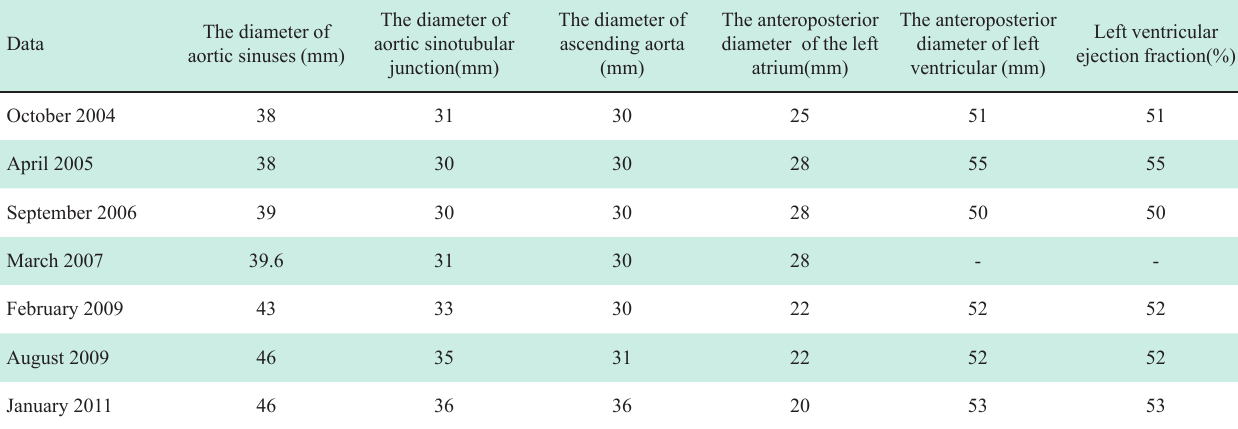
Table 1 Echocardiography results over the years from 2004 to 2011